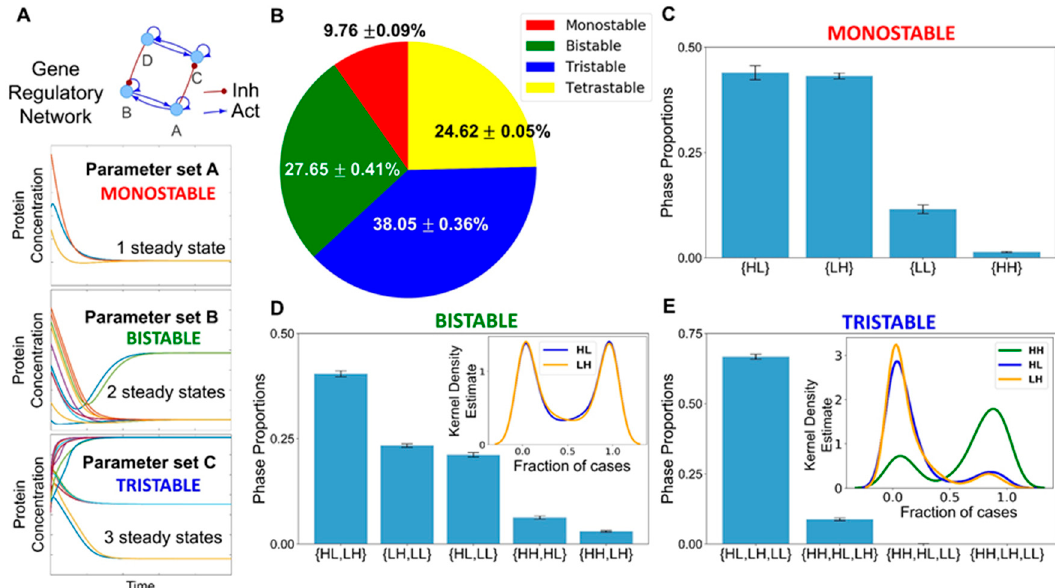
Figure 3. Co-existence and relative stability of multiple phenotypes giving rise to multi-stable phases. (A) Schematic showing how a gene regulatory network for different parameter sets end up in a mono- or a multi- (bi-, tri-) stable regime. Depending on different initial conditions, the system (levels of the different regulators) can converge to one or more steady state level(s), enabling mono- or multi-stability. (B) A pie chart showing the fraction of parameter sets giving rise to mono-, bi-, tri-, and tetra-stability (mean ± standard deviation over three independent replicates through RACIPE analysis). (C) Bar plot showing the proportions of the various phases of the monostable solutions, namely, {HL}, {LH}, {LL}, and {HH}. (D) Bar plot showing the proportions of the various phases possible for bi-stable solutions. The kernel density estimate plot in the inset shows the relative stability of the HL and the LH states for the phase {HL, LH}. (E) Bar plot showing the proportions of phases possible for the tri-stable solutions. The kernel density estimate plot in the inset shows the relative stability of HL, LH, and HH states for the phase {HL, LH, HH}. Error bars represent the standard deviation of the mean values of the phase proportions over three independent RACIPE replicates. Panels B–E are based on three replicates of RACIPE simulations on the network shown in Figure 1.